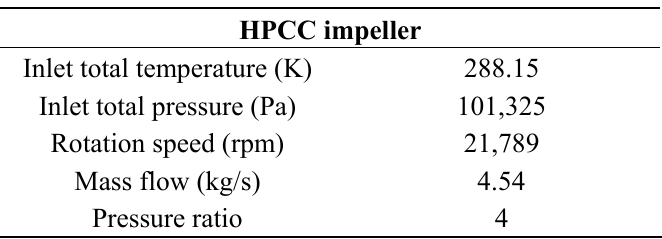
Table 1. Main specifications of